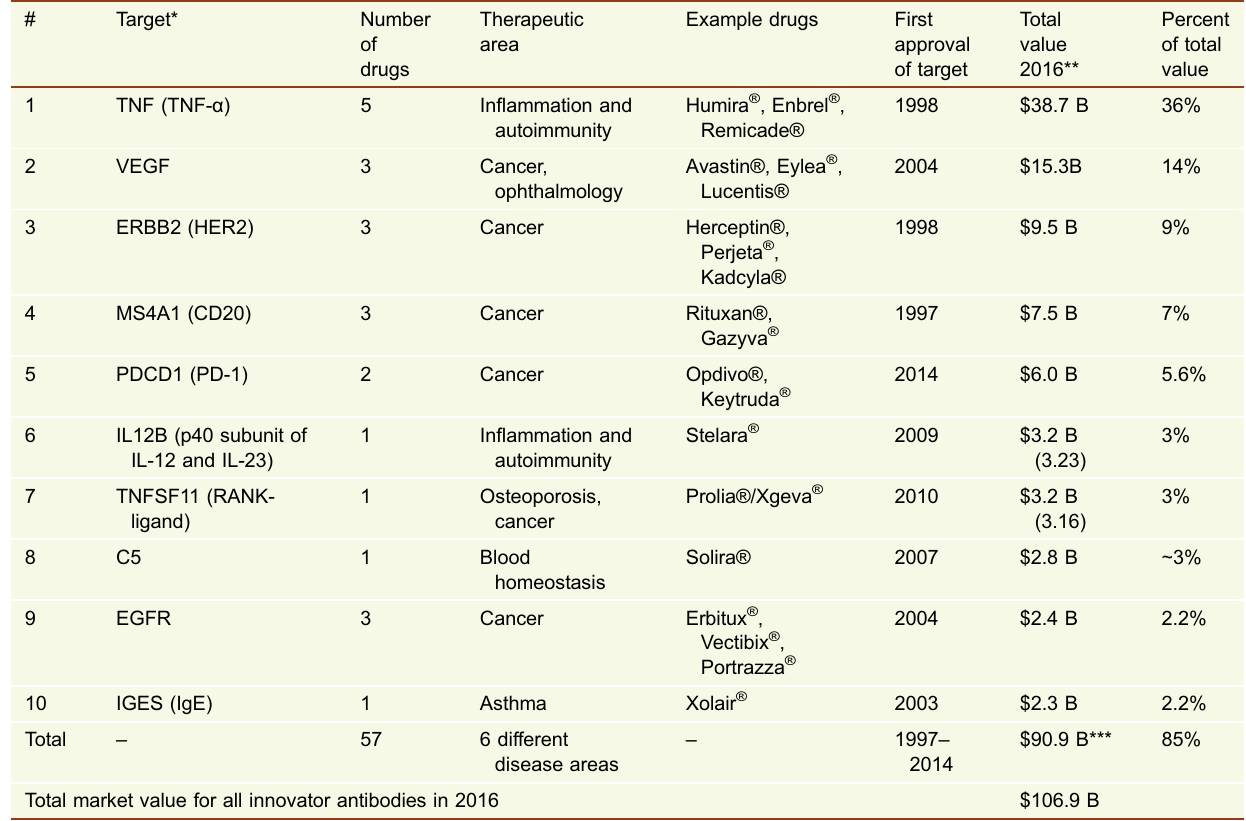
Table 7. Most valuable targets for Mabs and Fc fusion proteins as of full-year